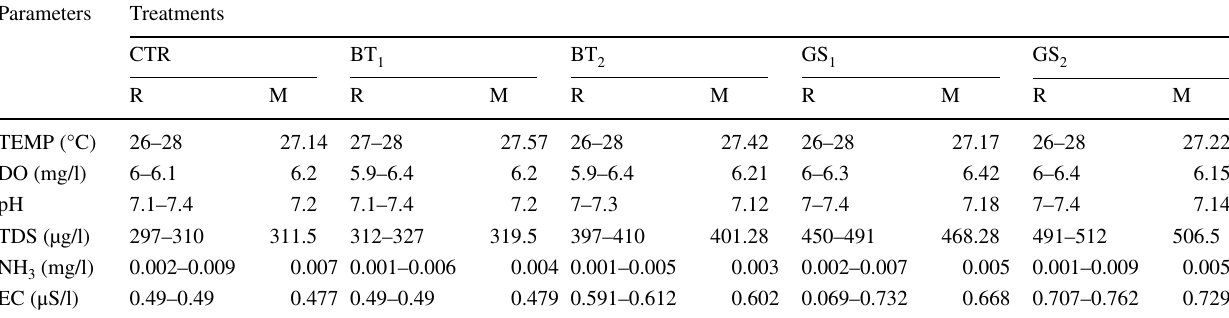
Table 5 Water quality criteria of tilapia fish reared in treated water with or without probiotics for 70 days